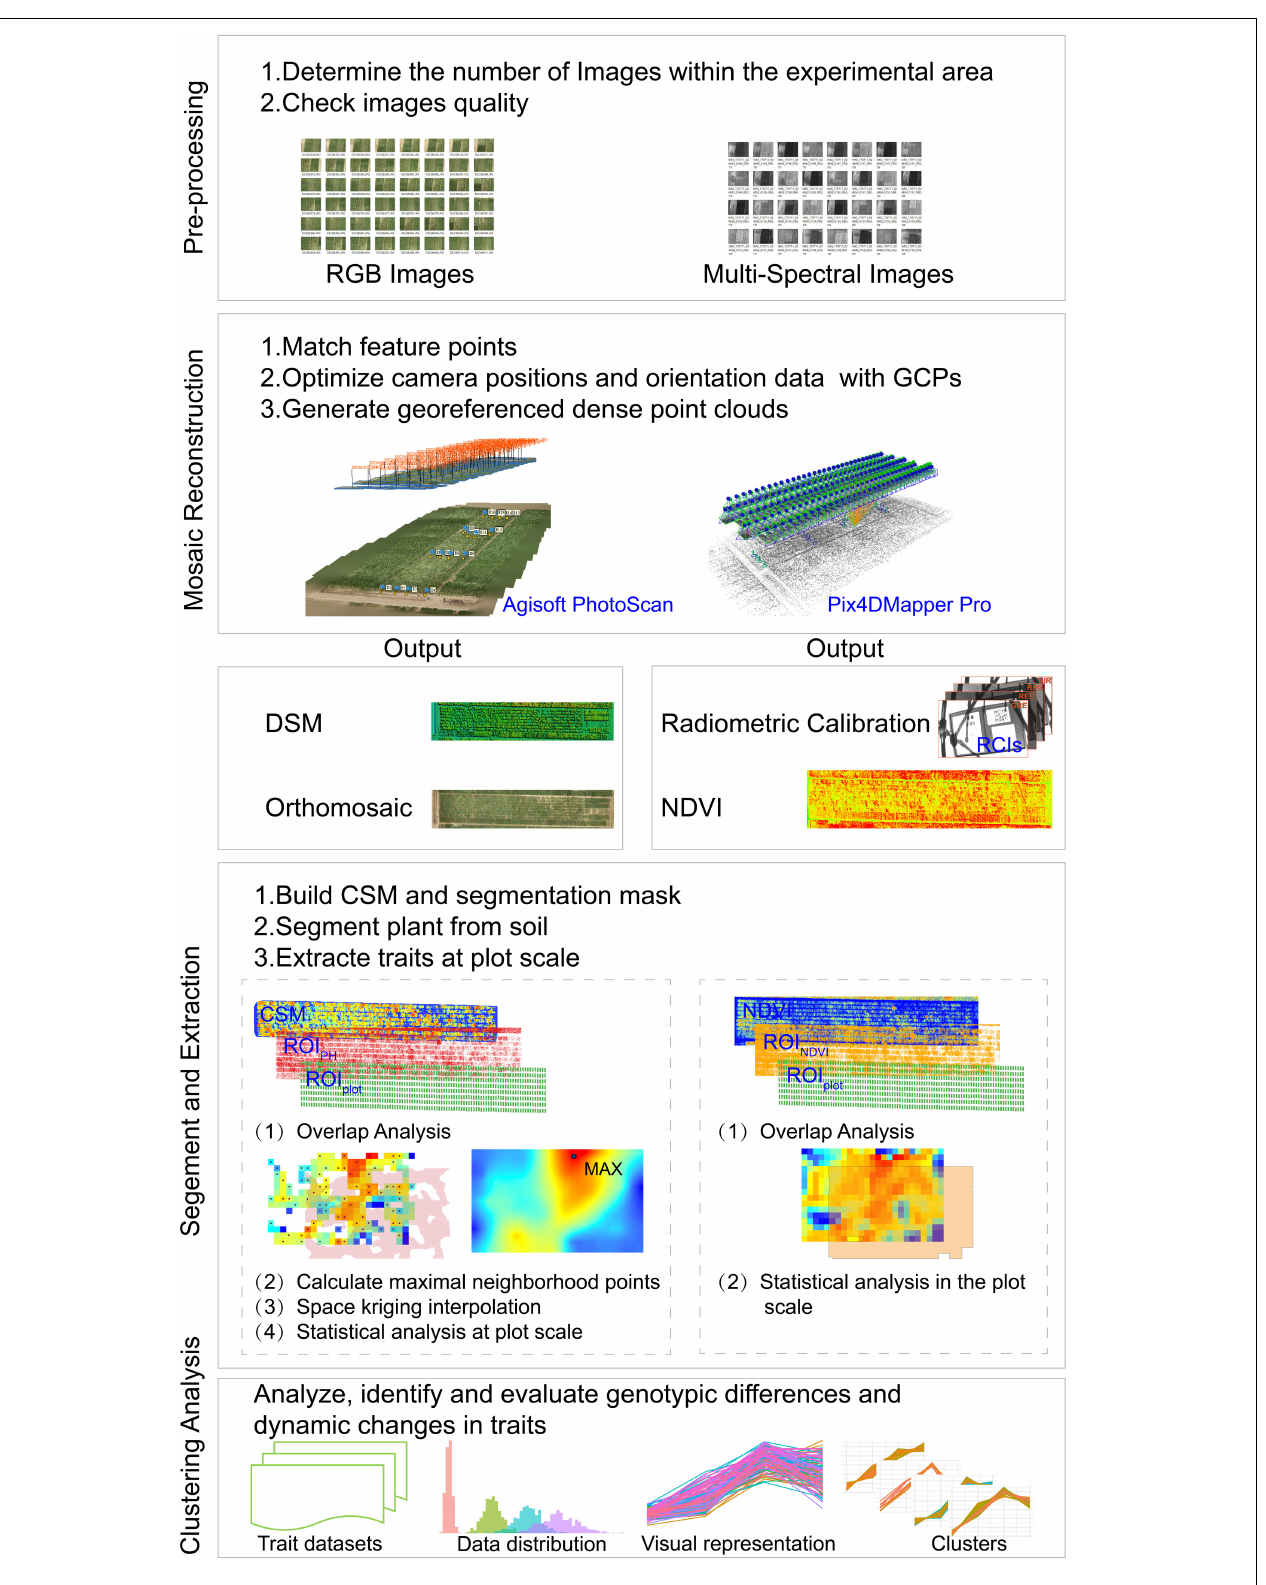
FIGURE 2 | The workflow for extraction, analysis and evaluation the genotypic difference and dynamics and development trend of traits derived from a UAV-HTPP.